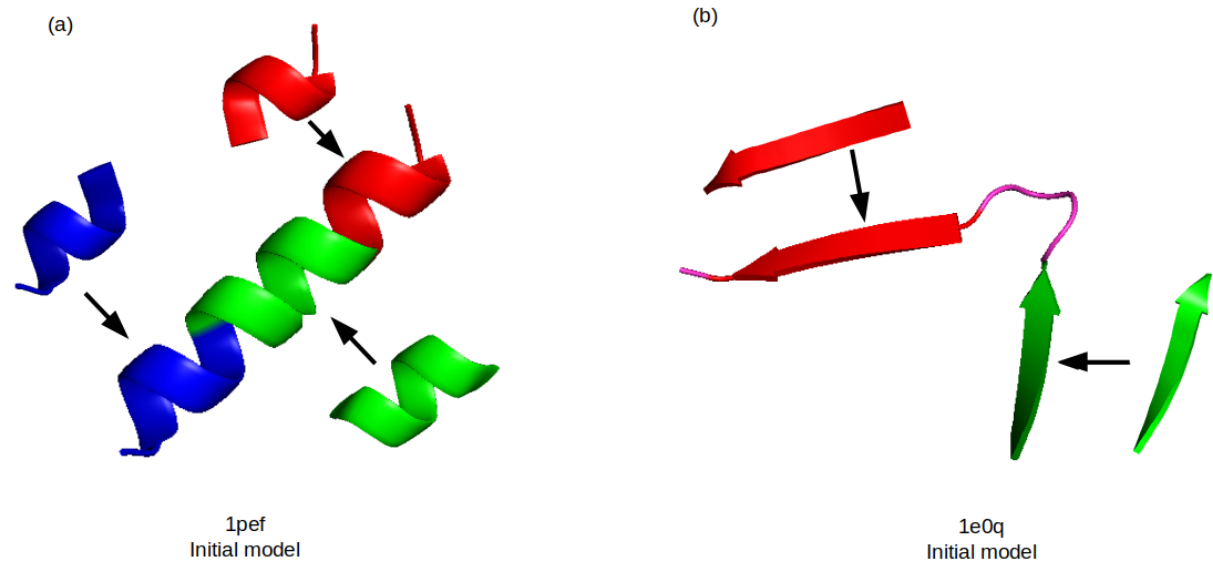
Figure 3. Two examples ( a , b ) of the initial models with the fragments generated by FCNN.